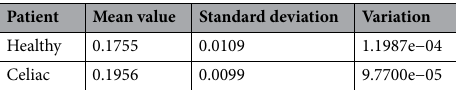
Table 4. Interpretation of the standard deviation of the light intensity